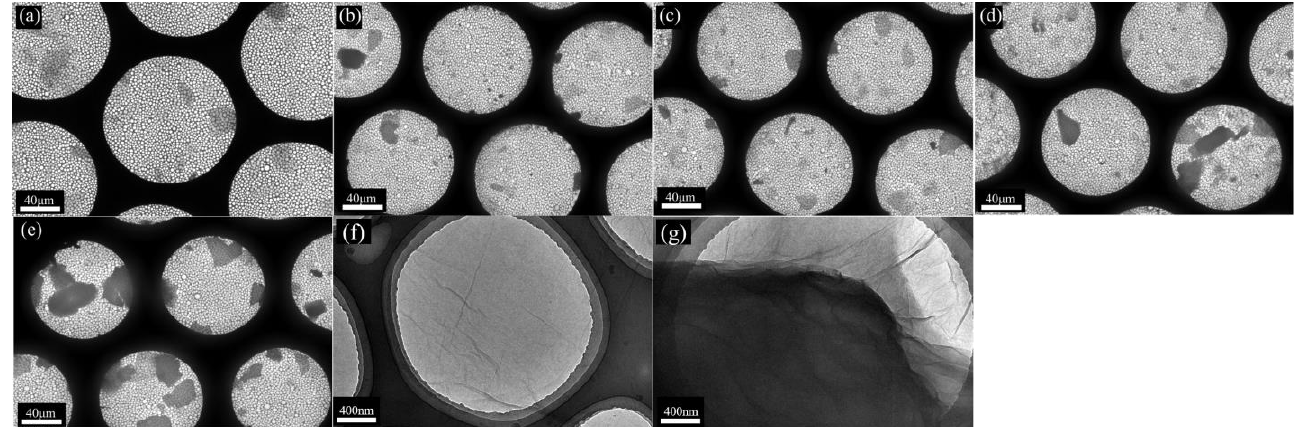
Figure 5. TEM images of the Gr ( a ) 120 s, ( b ) 180 s, ( c ) 240 s, ( d ) 300 s, and ( e ) 360 s. High magnification of the RGO with ( f ) fewer and ( g ) multiple layers.